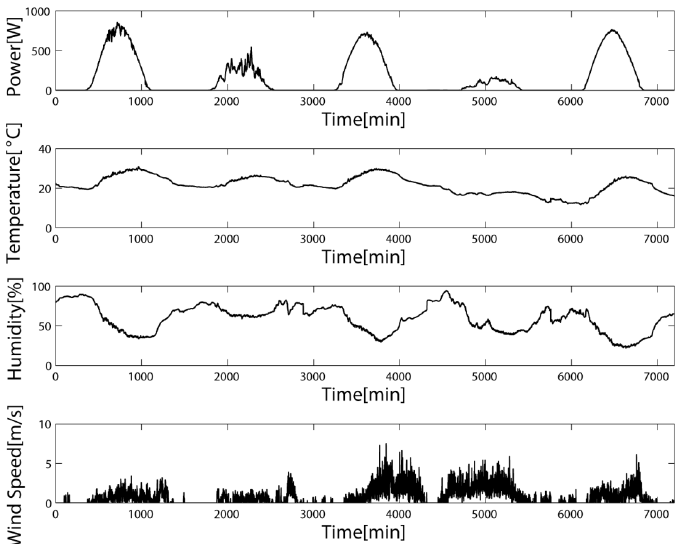
Figure 1. Output and meteorological factors of a PV power plant.